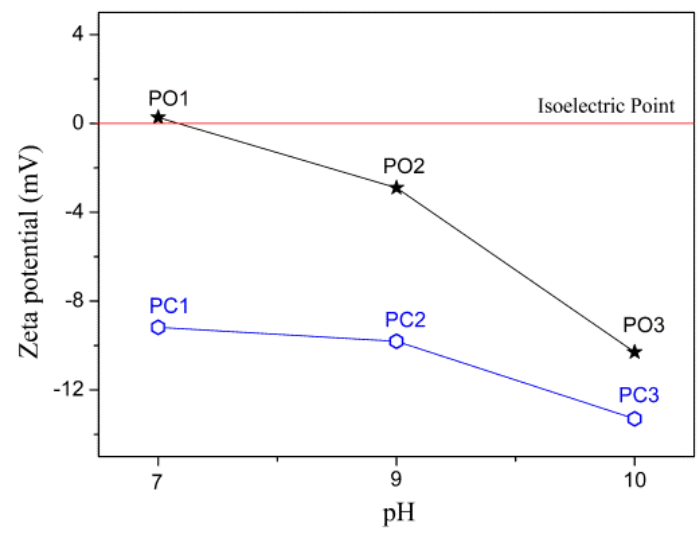
Figure 4. Zeta potential of filtrates as function of pH value.